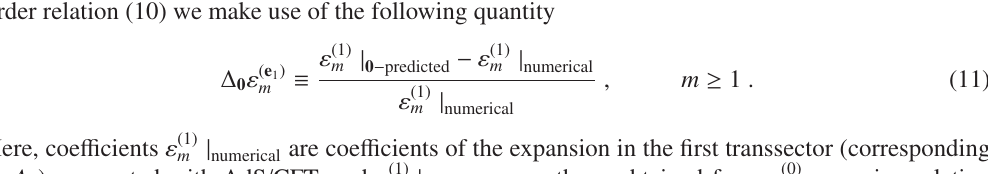
Figure 2. Poles of the Borel-Padé approximant BP 189